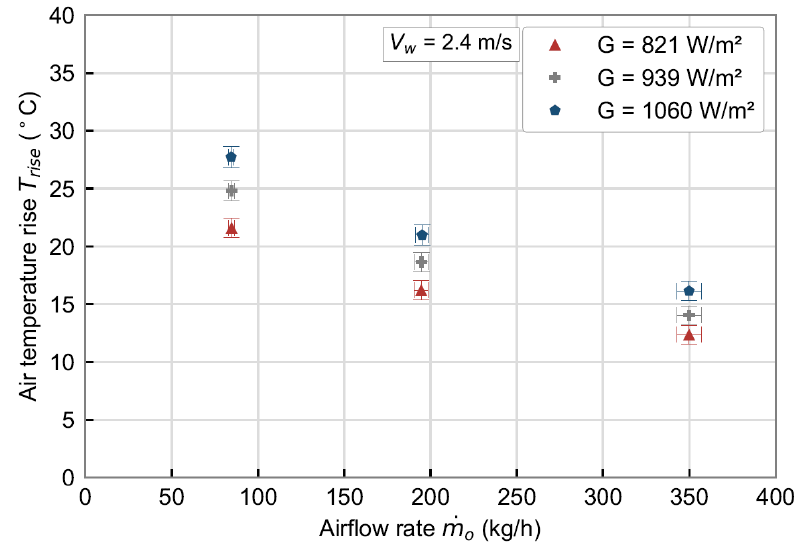
Figure 12. Temperature rise dependency to flowrate and irradiance.